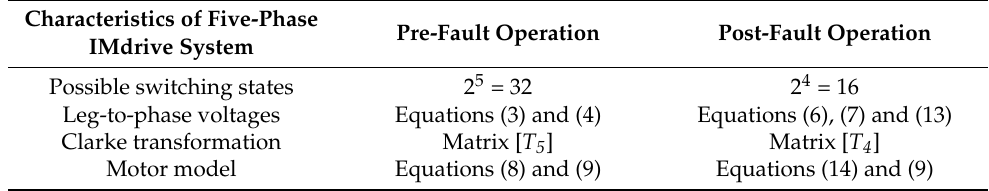
Table 1. Characteristics of five-phase IM drive in pre-fault and post-fault